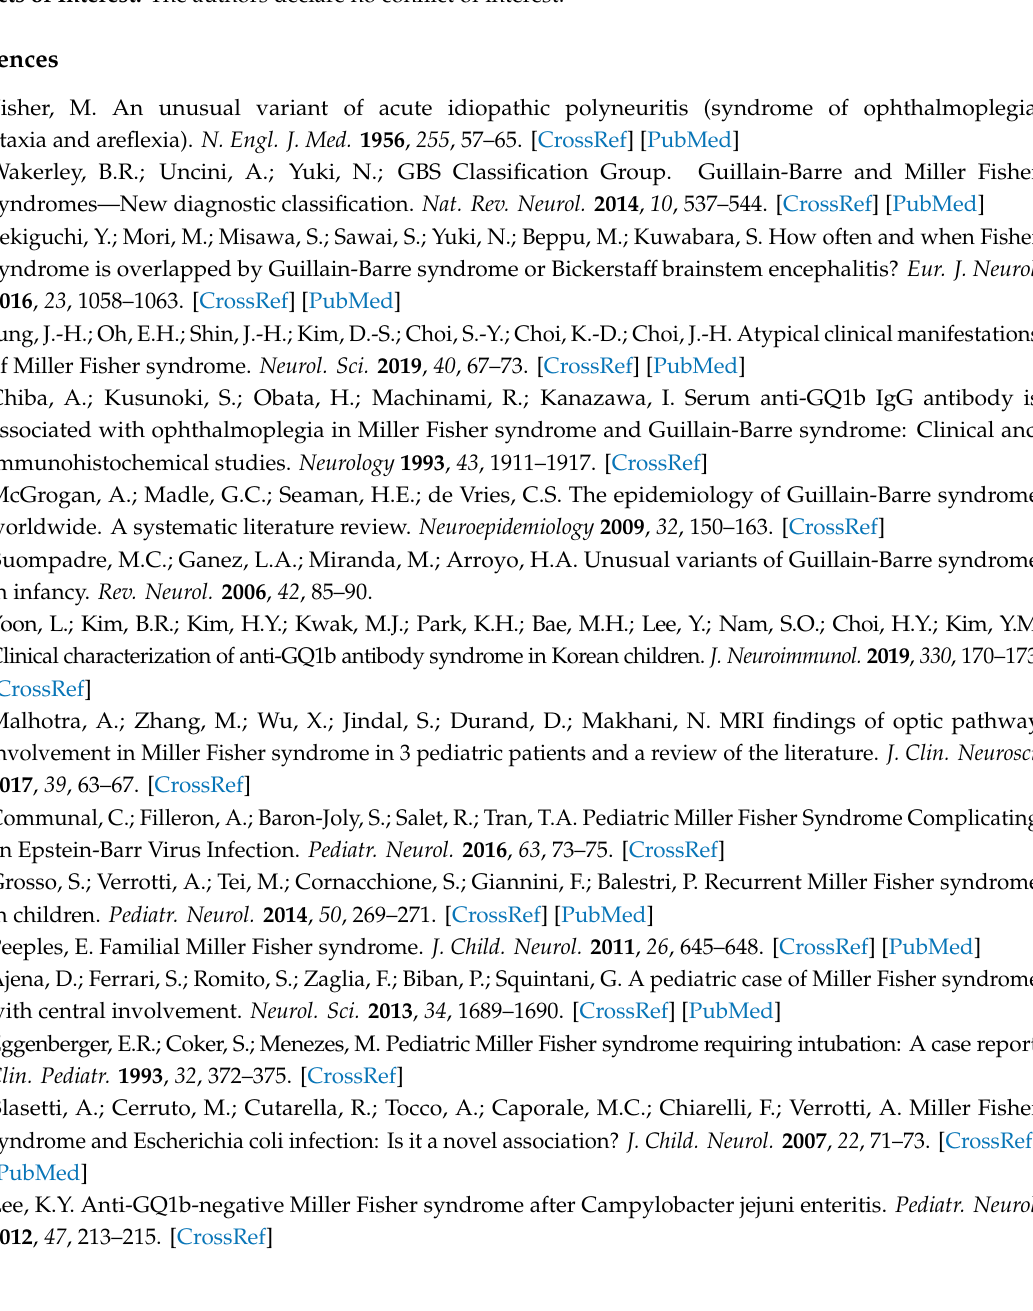
Table S1: Published cases of pediatric Miller-Fisher